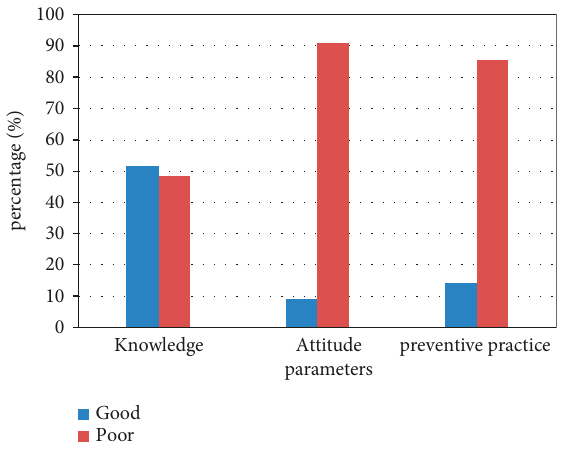
Figure 1: The knowledge, attitude, and preventive practice related to Onchocerciasis among Selamago woreda residents in 2021. Table 2: Distribution of factors associated with knowledge related to Onchocerciasis in Selamago in 2021.